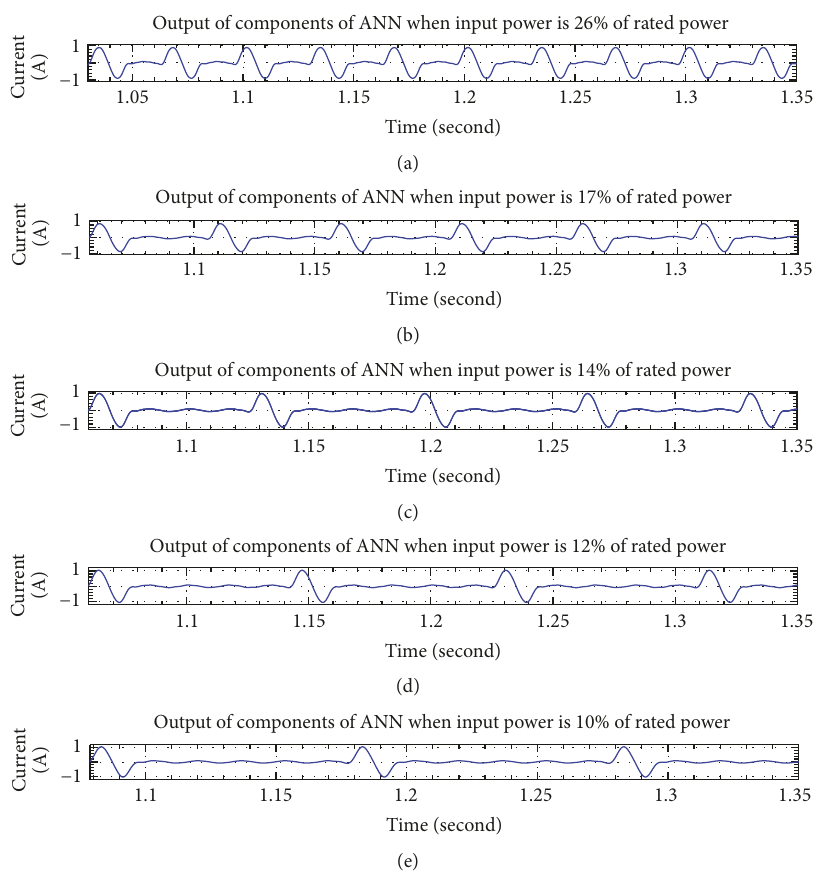
Figure 5: Current output waveforms of the microinverter during burst mode ((a–e) 26%, 17%, 14%, 12%, and 10%).